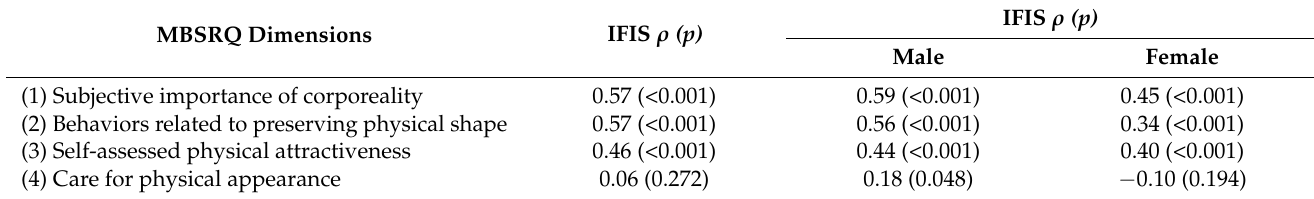
Table 4. Correlations between the MBSRQ dimensions and the IFIS questionnaire.